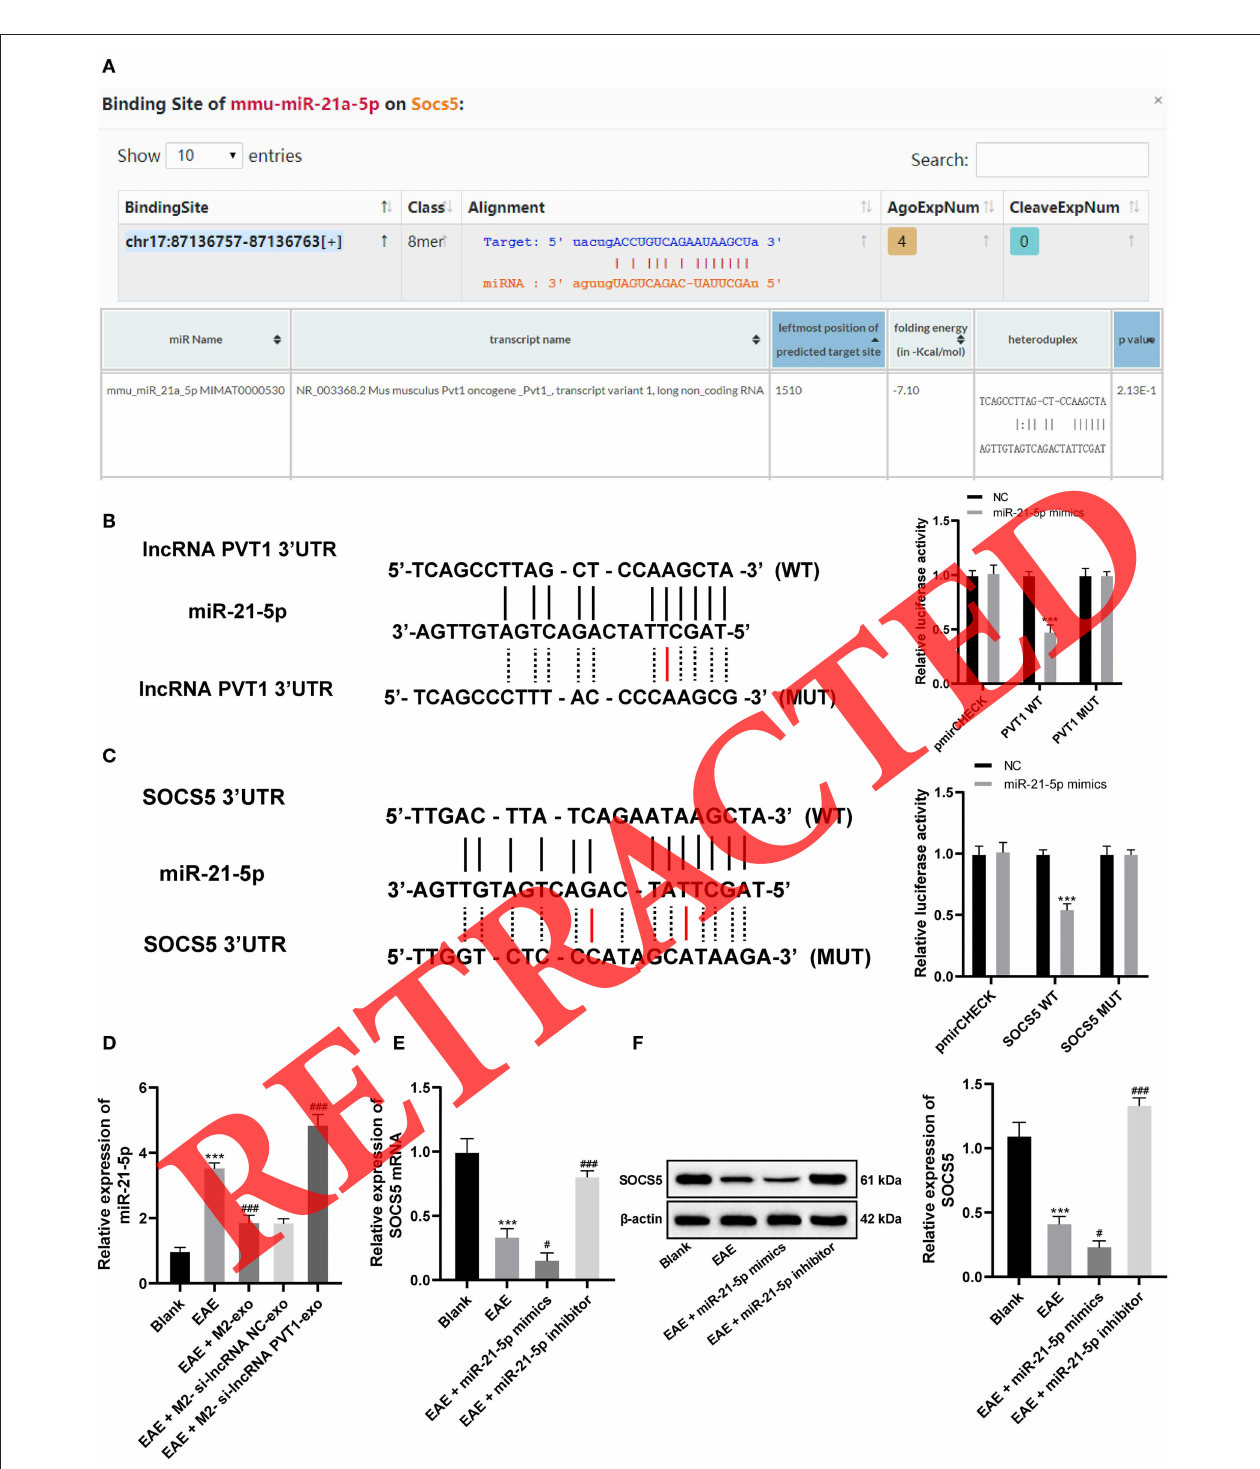
FIGURE 5 | LncRNA PVT1 competitively binds to miR-21-5p and upregulates SOCS5 expression in EAE mice. (A) Database (http://starbase.sysu.edu.cn, https://cm. jefferson.edu/rna22/Interactive/) analysis of binding relationship between lncRNA PVT1 and miR-21-5p, together with miR-21-5p, and SOCS5; (B,C) Targeting relationship between lncRNA PVT1 and miR-21-5p, together with miR-21-5p, and SOCS5 detected by dual-luciferase reporter gene assay, compared with the NC group, *** p < 0.001; (D) Relative miR-21-5p expression in spinal cord of EAE mice with different treatment detected by RT-qPCR; (E,F) mRNA and protein levels of SOCS5 in spinal cord of EAE mice with different treatment detected by RT-qPCR and western blot analysis. Compared with the blank group, *** p < 0.001; compared with the EAE group, # p < 0.05, ### p < 0.001. Data in (D–F) are analyzed with one-way ANOVA, in (B,C) are and analyzed with two-way ANOVA, Tukey’s multiple comparisons test was utilized for post hoc test n =